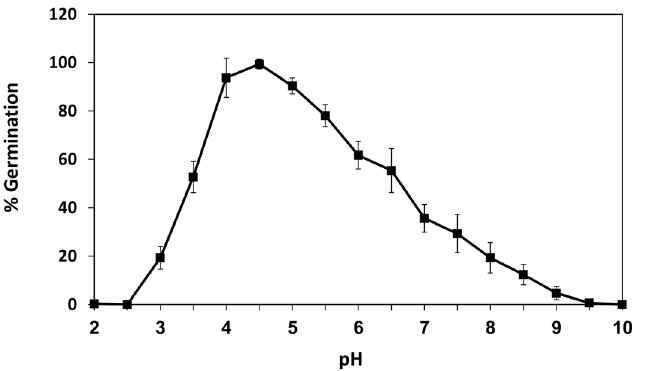
Fig 1. Effect of pH on Rhizopus delemar spore germination. Percentage of R . delemar spores germinated under different pH conditions. Spores were incubated in SPAF solution (20 mg/ml, 42°C) and scored at 6 h. Values are means ± SE (n =